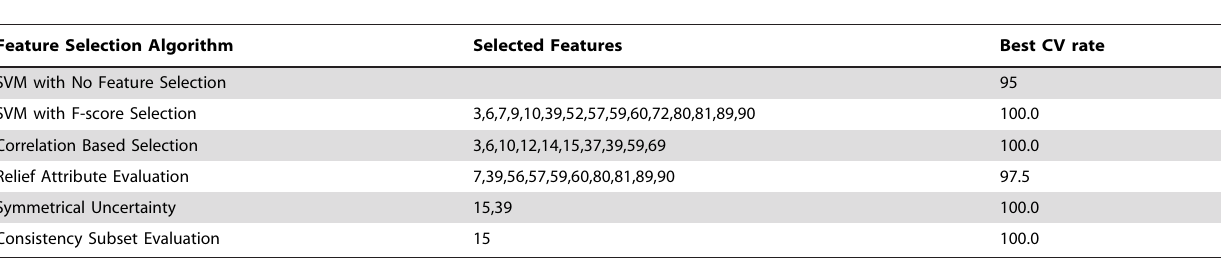
Table 6. Epithelial vs Mesenchymal comparison in ROCK-inhibitor-treated